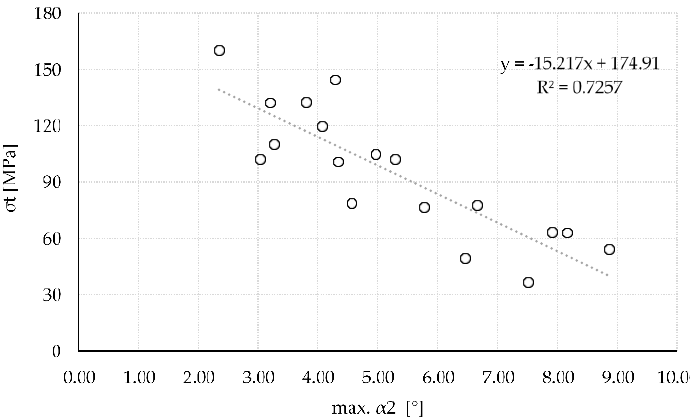
Figure 6. Influence of max. α2 on the tensile strength of n = 18 samples (r = −0.852).